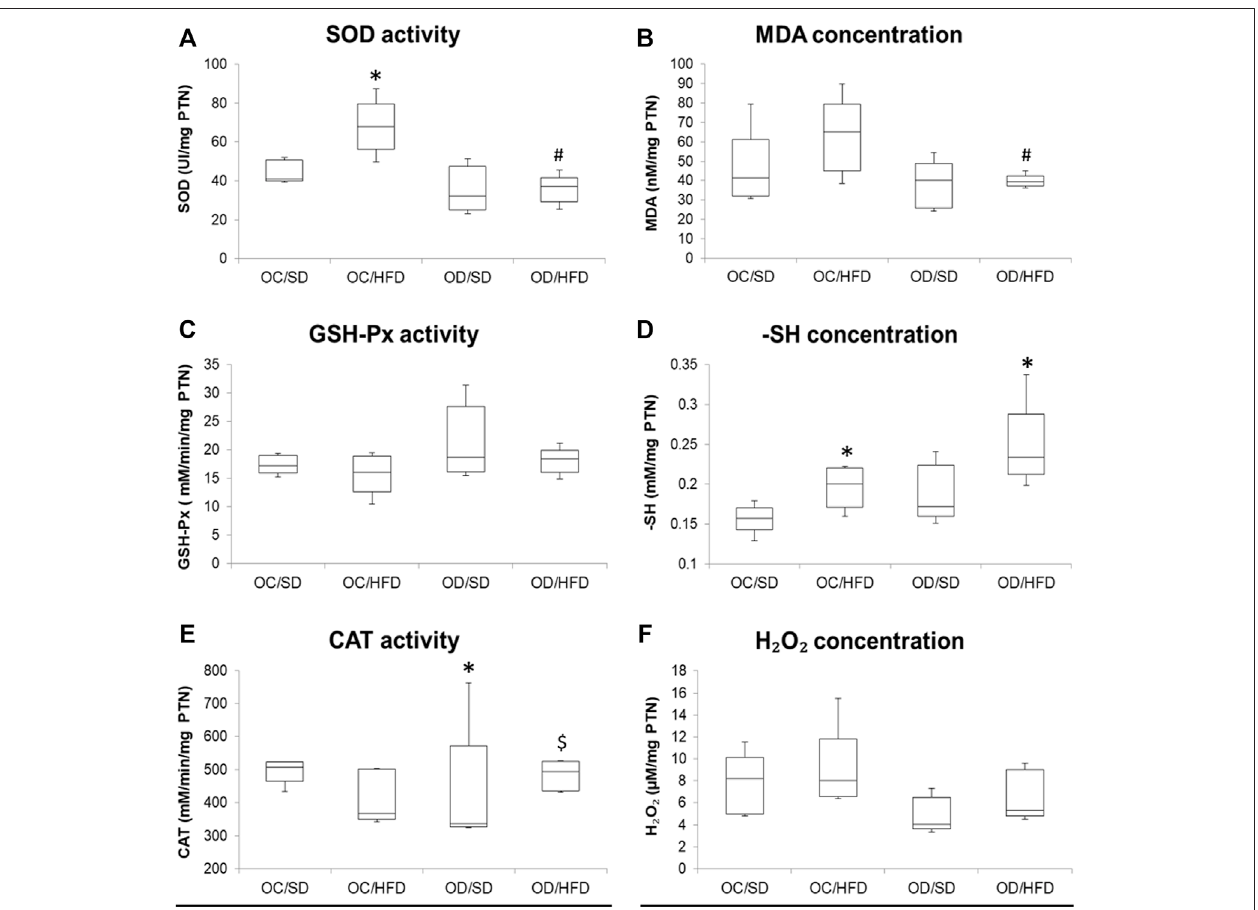
FIGURE4|(A) SOD,superoxidedismutaseactivity; (B) MDA,malondialdehydeconcentration; (C) GSH-Px,glutathioneperoxidaseactivity; (D) -SH,reducedthiol groups concentration; (E) CAT, catalase activity, and (F) H 2 O 2 , hydrogen peroxide concentration in maternal liver at full-term pregnancy from OC, control offspring; and OD,diabeticoffspring thatreceived aSD,standarddietor HFD,high-fatdiet;from weaning. Valuesare expressed asmean ±SD, standarddeviation; n =10rats/group. * p < 0.05 — compared tothe OC/SD group; # p < 0.05 — compared tothe OC/HFD group; $ p < 0.05 — compared tothe OD/SD group (Tukey Multiple Comparison